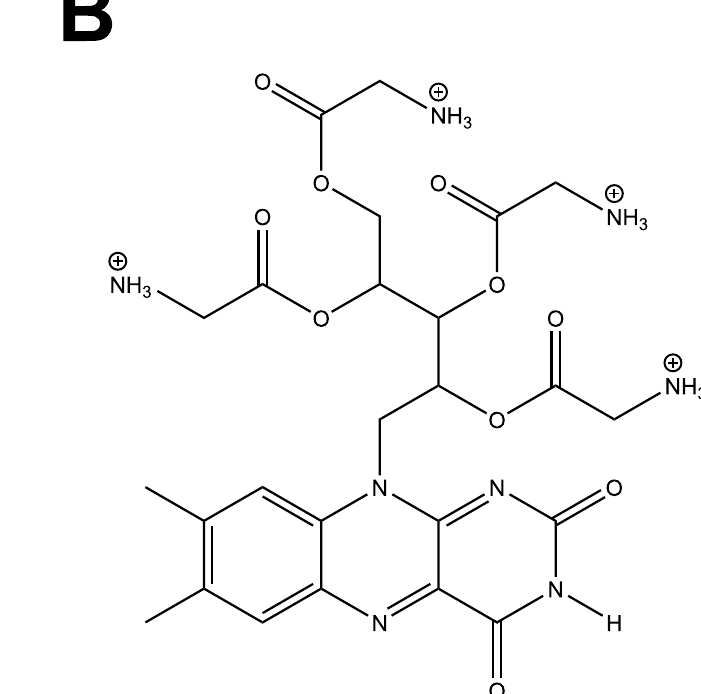
PLOS ONE | https://doi.org/10.1371/journal.pone.0253212 June 11,